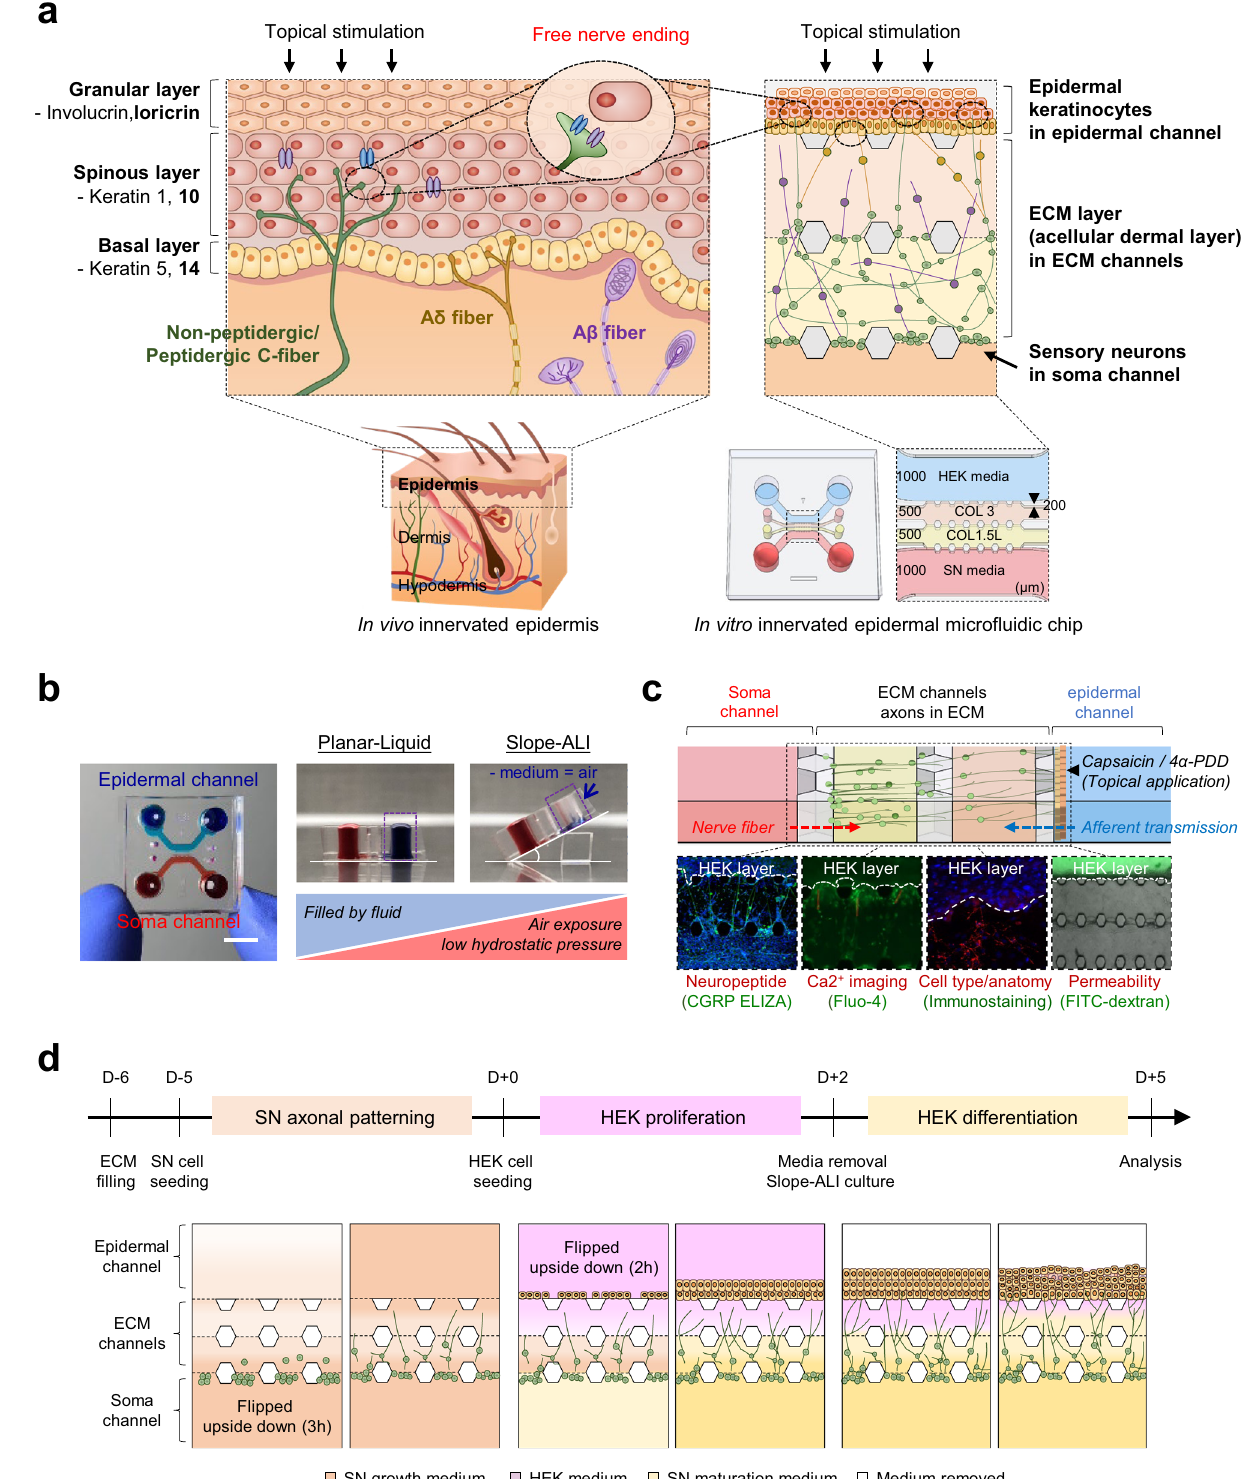
Fig. 1 | Micro fl uidic platform and culture system for sensory neurons- keratinocytes co-culture. a Schematic illustration and design of human skin anatomy(left)andtheinnervatedepidermalchiptococulturesensoryneuronsand keratinocytes (right). Schematic design of the innervated epidermal chip com- partments (right lower). HEK; human keratinocyte, SN; sensory neuron, COL 3; collagen I at 3mg/ml concentration, COL 1.5L; collagen I at 1.5mg/mL with 10%